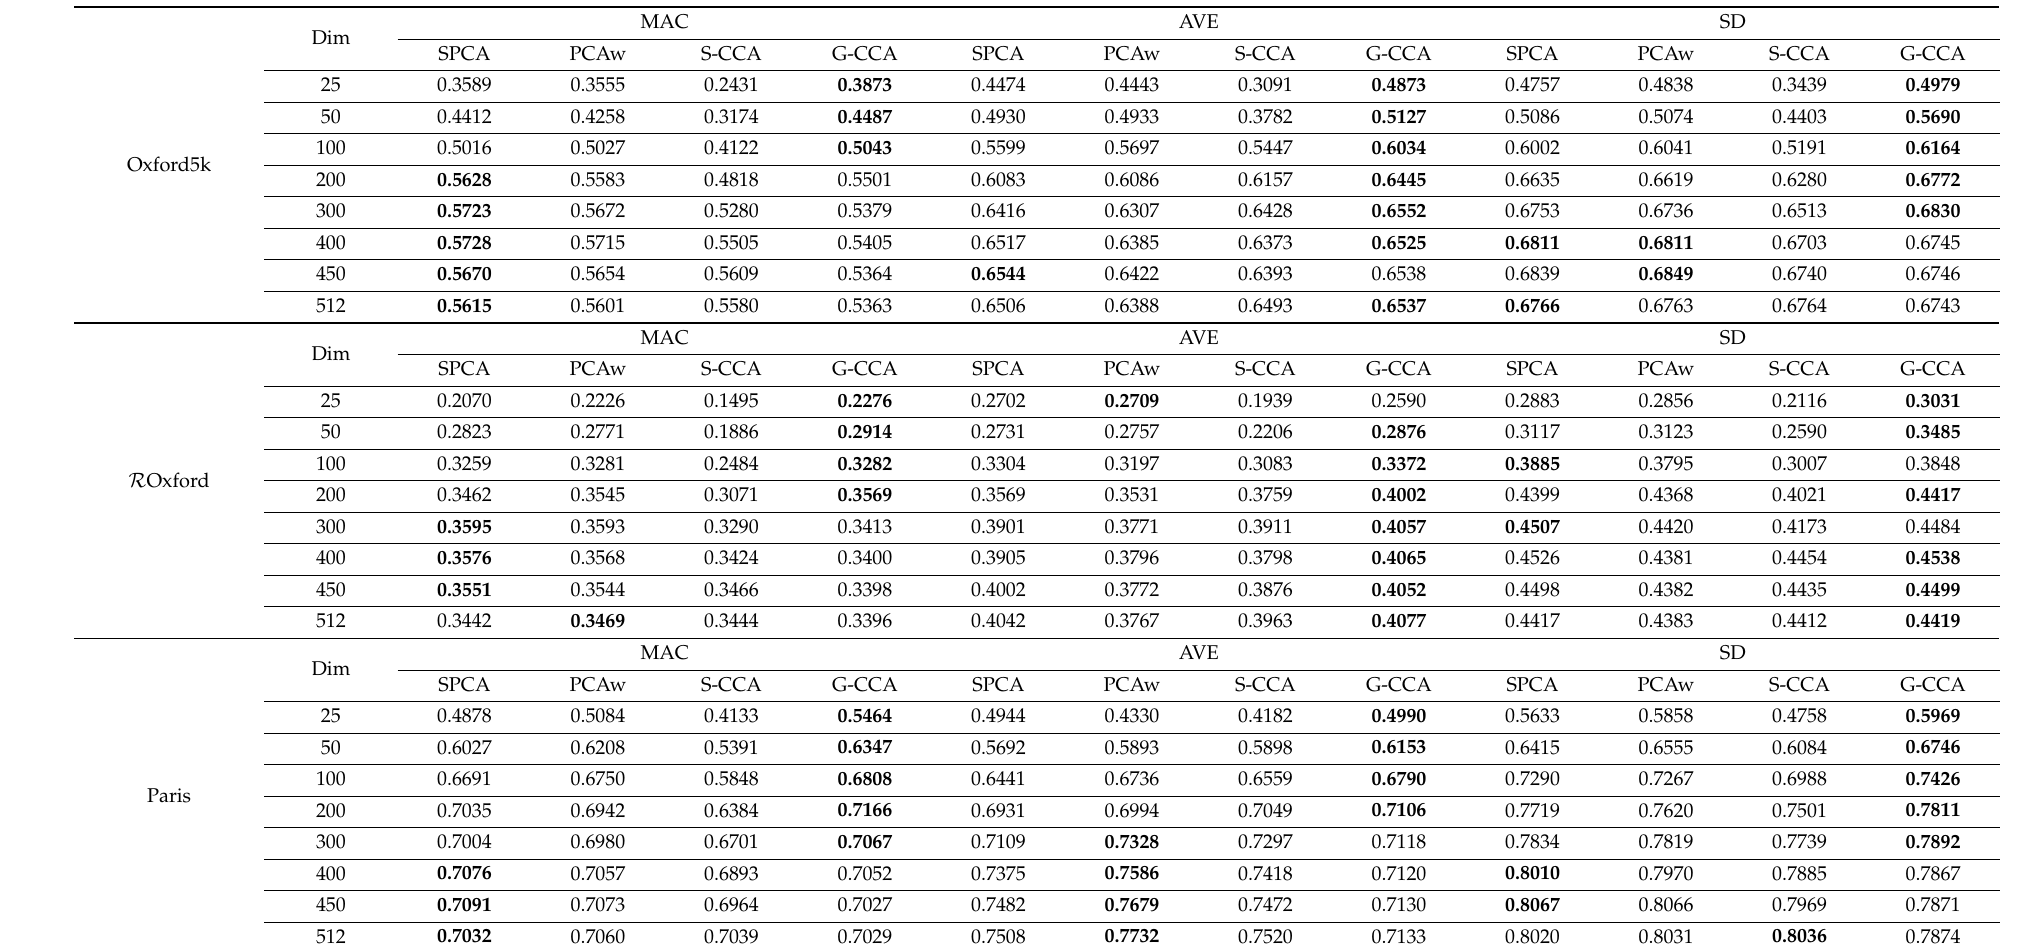
Table 3. Evaluation results from 30k-SfM on Oxford5k, R Oxford, Paris6k, and R